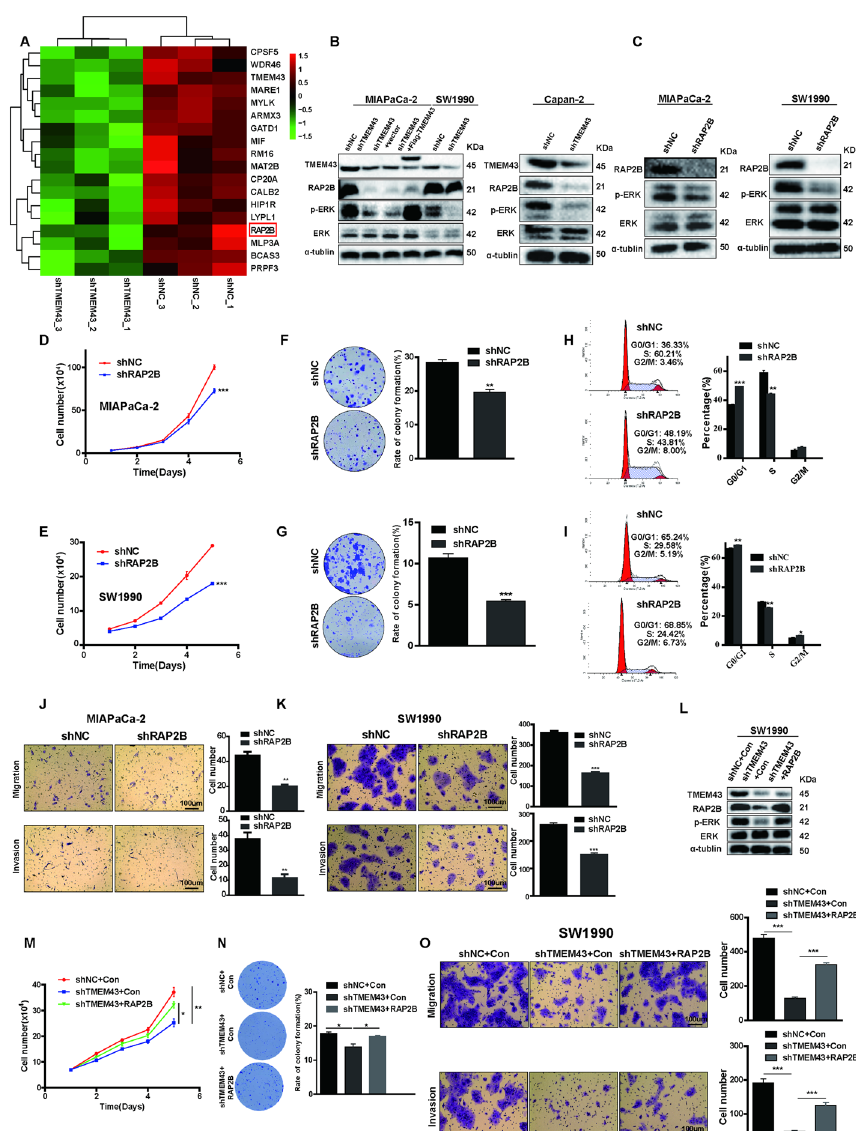
Fig. 3 The RAP2B/ERK pathway is essential for TMEM43-mediated pancreatic cancer progression. A Heatmap showing proteins with partly differential expression in TMEM43-silenced MIAPaCa-2 cells and control cells. B RAP2B, ERK, and p-ERK protein expression levels were detected in TMEM43-silenced, TMEM43-overexpressing cells, and the corresponding control cells. C The indicated protein expression levels were measured in RAP2B-silenced cells and control cells. D , E Cell proliferation abilities were determined in RAP2B-silenced MIAPaCa-2 cells ( D ), SW1990 cells ( E ), and the corresponding control cells using the cell counting assay. F , G Colony formation assays showed the effect of RAP2B expression levels on the growth abilities of MIAPaCa-2 cells ( F ) and SW1990 cells ( G ). H , I The cell cycle in RAP2B-silenced MIAPaCa-2 ( H ), SW1990 cells ( I ), and the corresponding control cells were detected using flow cytometry assays. J, K The migration and invasion abilities were detected in RAP2B-knockdown MIAPaCa-2 ( J ), SW1990 cells ( K ), and control cells. L Western blot showing the protein expression level in SW1990 cells stably transfected with control, shTMEM43, or shTMEM43 plus RAP2B. M–O Cell counting, colony formation, and transwell assays showing that the suppression of proliferation, migration, and invasion by shTMEM43 in SW1990 cells was partially abolished by RAP2B. Scale bar 100 μm. Results are shown as the mean SD of three independent replicates. * p < 0.05, = ± ** p < 0.01, *** p <